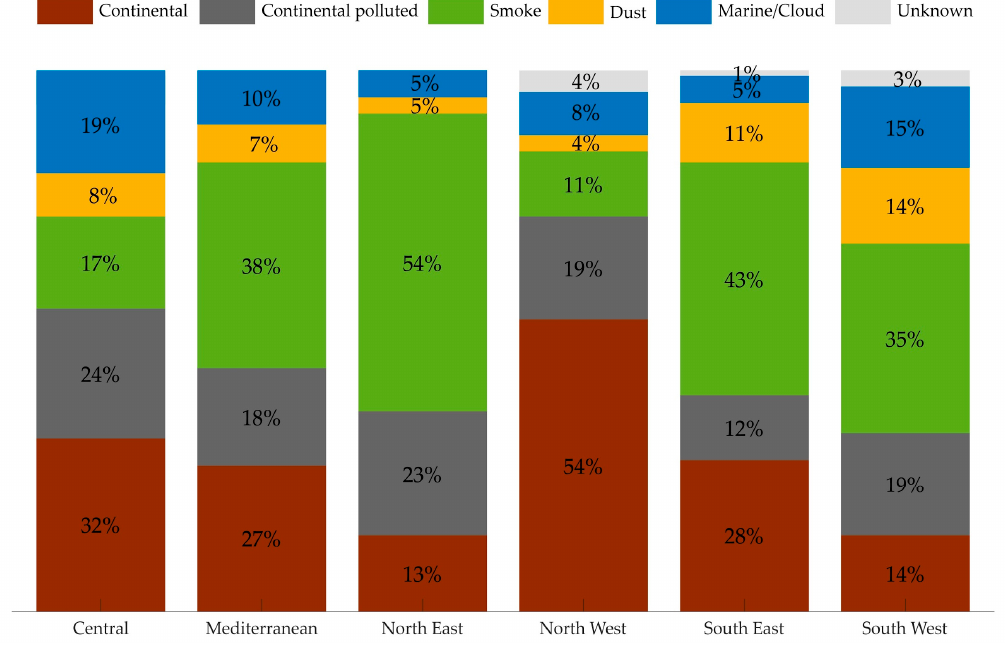
Figure 4. Prevalence of aerosol types retrieved with the Neural network Aerosol Typing Algorithm based on LIdar data (NATALI) code from EARLINET lidar measurements between 2008 and 2018.